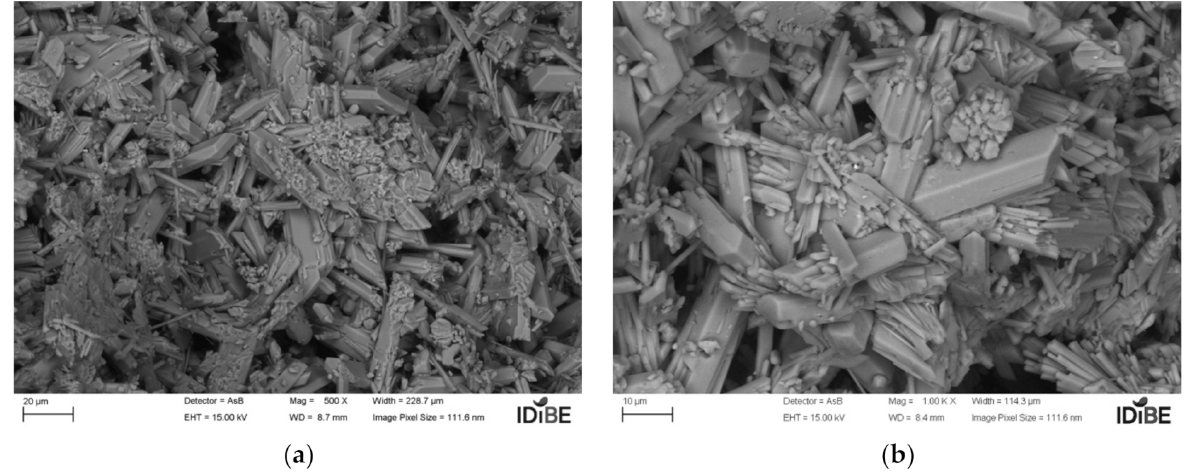
Figure 17. Micrograph of the 0.12% citric acid compound (lot I3): ( a ) 20 µ m; ( b ) 10 µ m (source: the